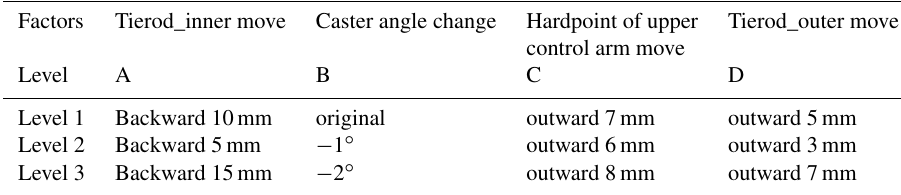
Table 10. The second parameter combination of the control factor level. Factors